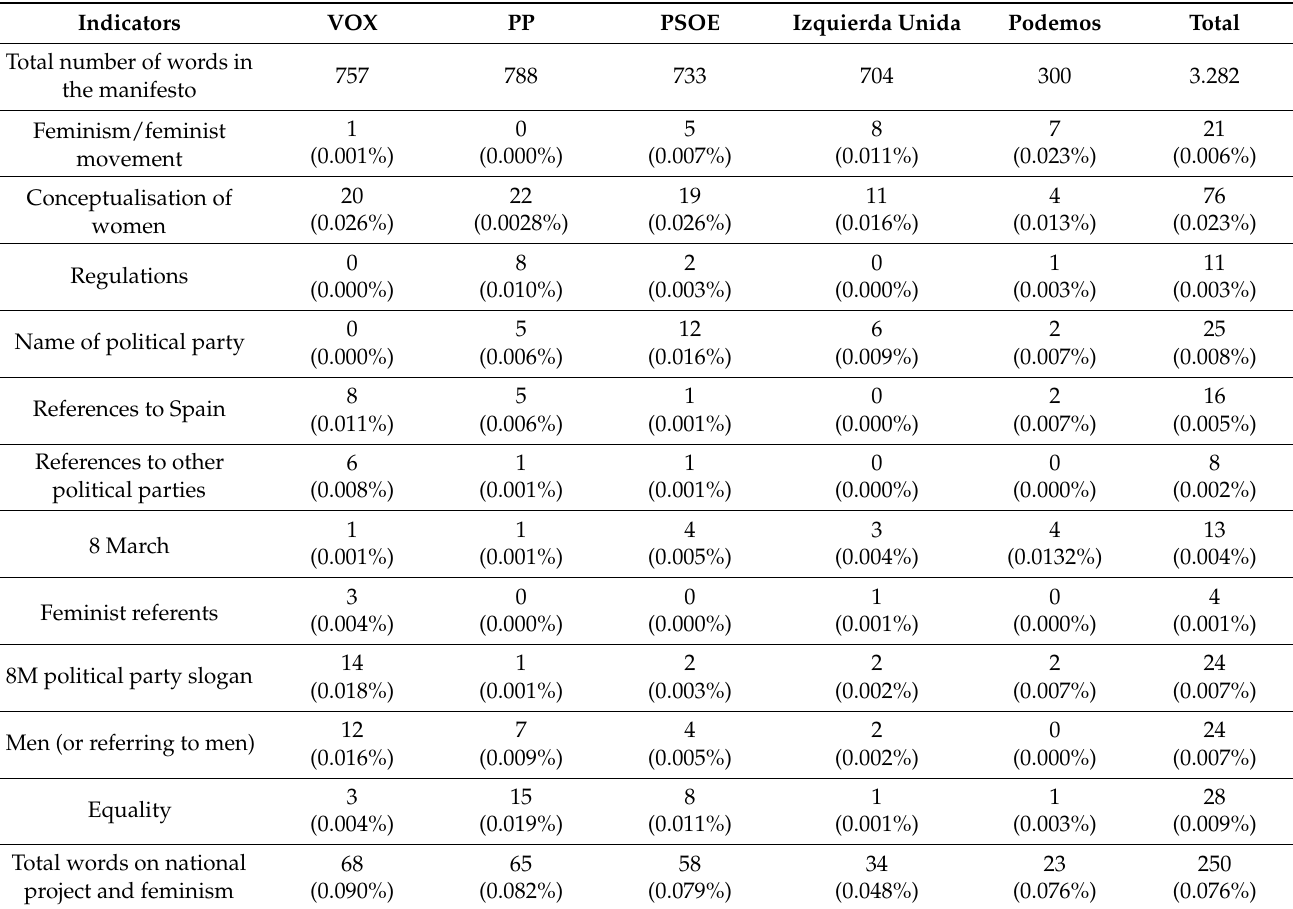
Table 2. Quantification of concepts, frequency of appearance and percentage according to the total number of words in each manifesto. Source: The authors’ own elaboration from 8M manifestos from each political